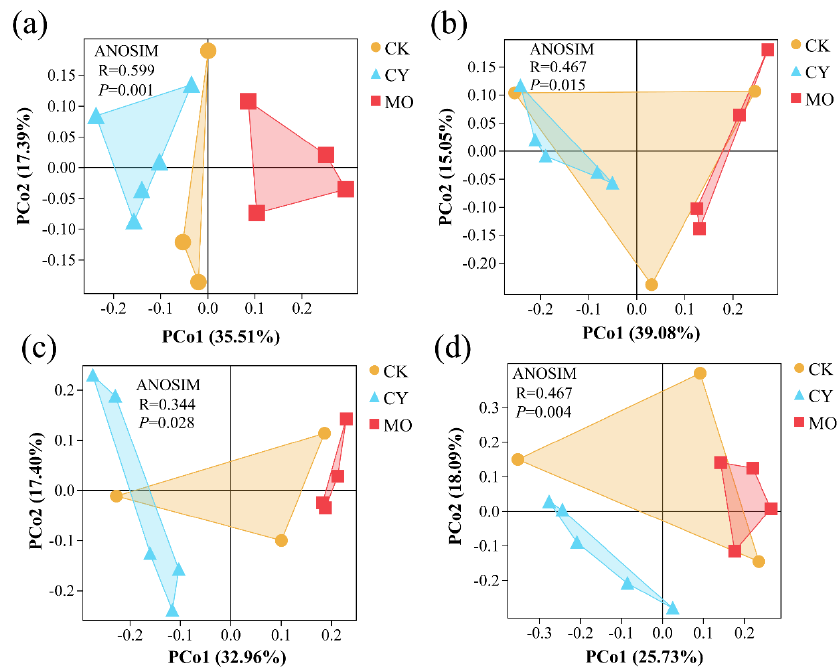
Figure 4. PCoA analysis and an ANOSIM test of the differences among ( a ) bacterial, ( b ) phytoplankton, ( c ) zooplankton, and ( d ) fungal communities in different groups based on OTU level. Distance between bacterial communities was calculated using the weighted-unifrac method, while distance between phytoplankton, zooplankton, and fungal communities was calculated using the unweighted-unifrac method.